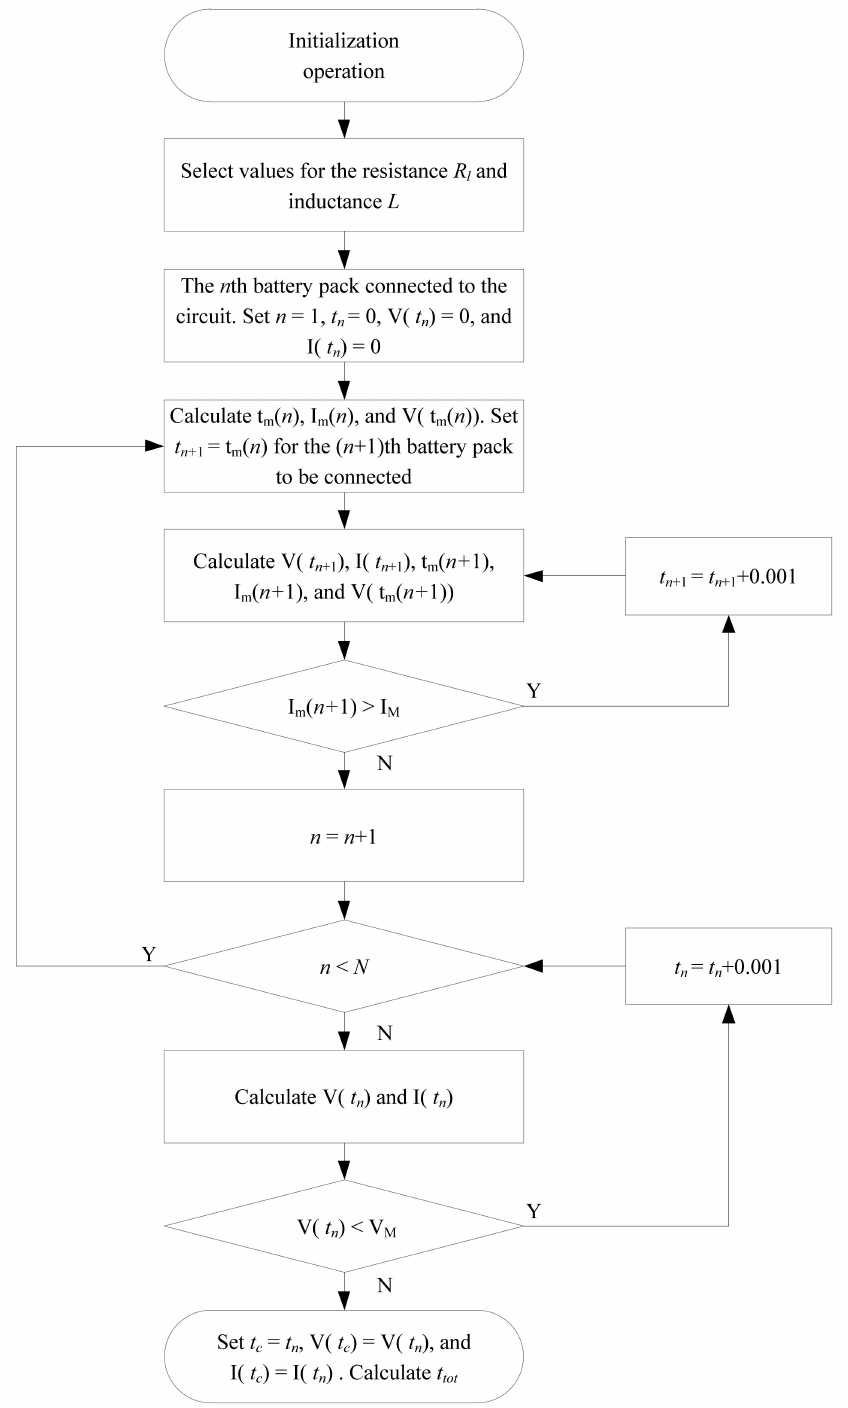
Figure 5. The flow chart of the procedures for calculating the total charging